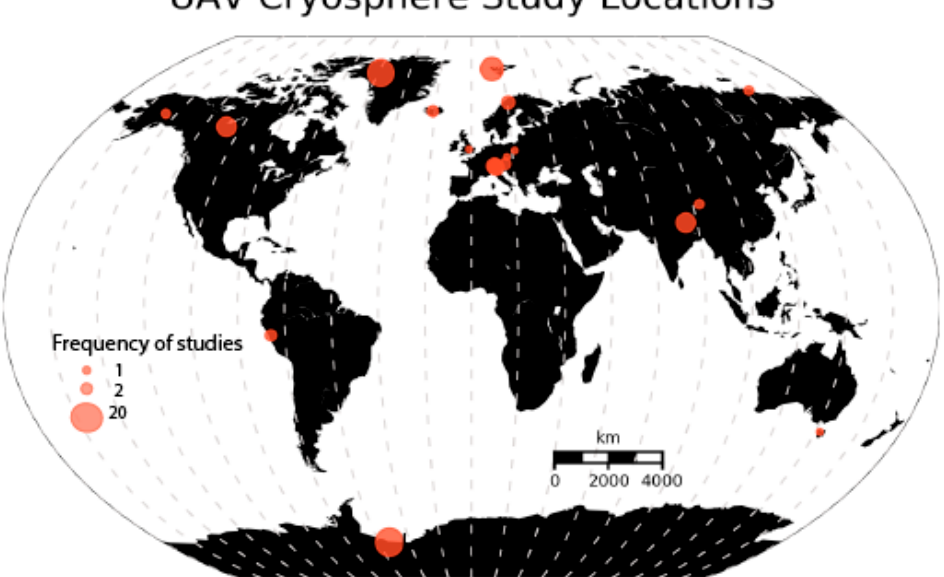
Figure 2. Global distribution of the reviewed study sites. The point size indicates the relative number of UAV flights completed within the peer-reviewed journals, conference proceedings, and university degree theses published online between 2014 and 2019.